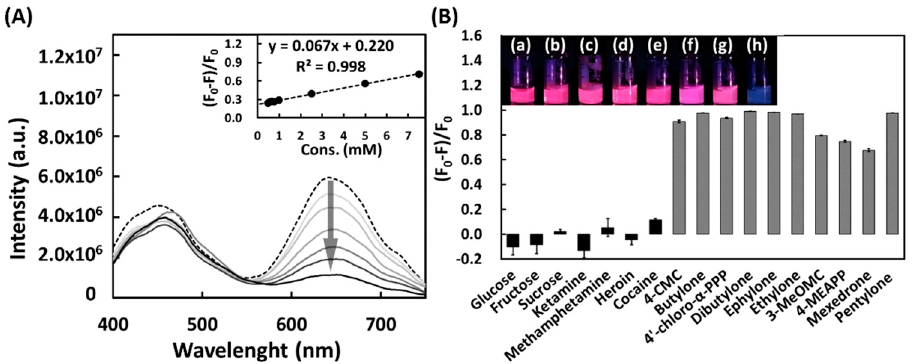
Figure 2. Detection of 4-CMC using BSA-Au NCs. ( A ) PL spectrum of BSA-Au NCs in sodium phosphate buffers (pH 7.0), without and with 4-CMC, using an excitation wavelength of 365 nm. ( B ) Selectivity of BSA-Au NCs toward cathinone drugs over other common illicit drugs and additives when excited at 365 nm (all analytes were 25 mM). Inset in ( A ) is the linear relationship (F 0 − F)/F 0 of the BSA-Au NCs against 4-CMC concentrations in the range 0.48–7.5 mM, where F and F 0 are the PL intensities of BSA-Au NCs at 650 nm with and without 4-CMC, respectively. Inset in ( B ) are PL images of BSA-Au NCs probe solutions containing ( a ) glucose, ( b ) fructose, ( c ) sucrose, ( d ) ketamine, ( e ) methamphetamine, ( f ) heroin, ( g ) cocaine, and ( h ) 4-CMC. Data were obtained through three measurements.